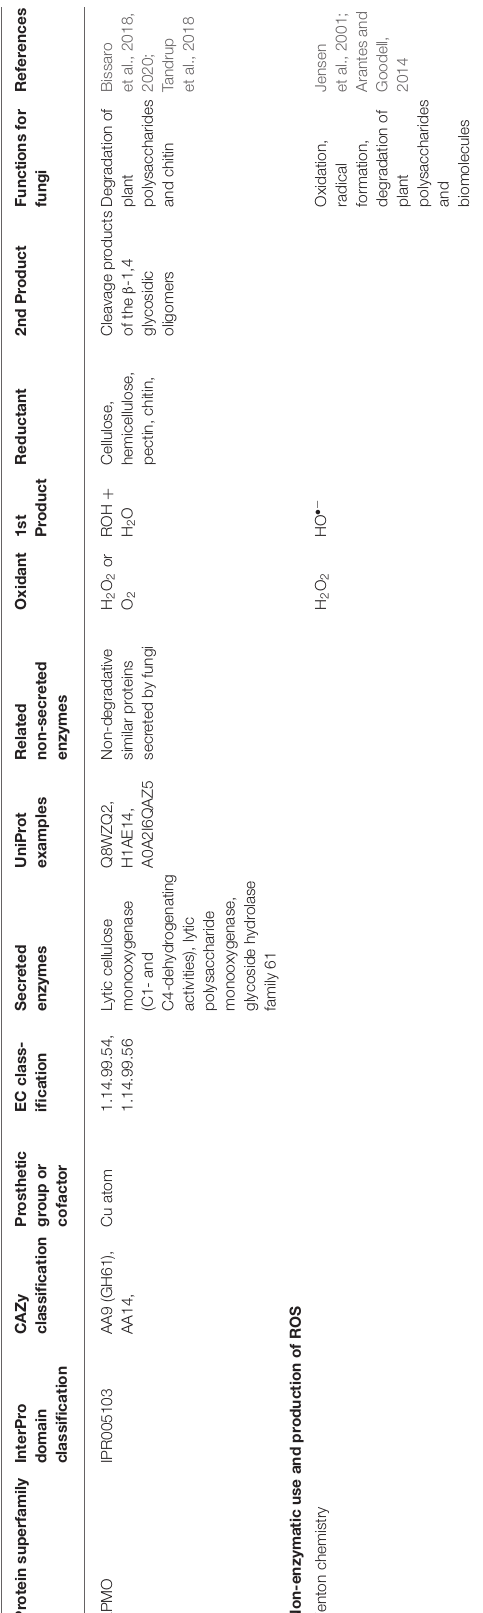
According to our bioinformatic search, all GMC-AA3 oxidoreductase-encoding genes are much less prevalent in the Basidiomycota classes Dacrymycetes , Tremellomycetes , and Wallemiomycetes as well as in the subphyla Ustilaginomycotina and Pucciniomycotina , compared to species of Agaricomycetes ( Figure 2A , Supplementary Table 1 ). Expansion of GMC-AA3 genes in Agaricomycetes was recently discussed in an extensive comparative genomics study with suggestion for their role in fungal development (Krizsán et al., 2019). The AA3_2 enzyme aryl-alcohol oxidase (AAO) is a secreted enzyme acting to produce extracellular H 2 O 2 or acting as potential reductant in redox-coupled electron transfer for other oxidoreductases (Martínez et al., 2009; Ferreira et al., 2015; Bissaro et al., 2018). Based on the localization predictions, this holds true for a majority (83%) of the protein models classified as aryl-alcohol oxidase in this study. For the predicted homologs of pyranose dehydrogenase (PDH), however, only 17 genes remained among the Basidiomycota genomes after identity threshold filtering. In agreement with a recent study (Sützl et al., 2019), putative PDH were found in species of Agaricomycetes family Agaricaceae ( Agaricus bisporus and Coprinopsis cinerea in this case), and the predicted proteins all demonstrated extracellular localization (secretion signal with one exception) ( Figure 2A , Supplementary Table 1 ). Among the alcohol oxidase (AOx) candidates